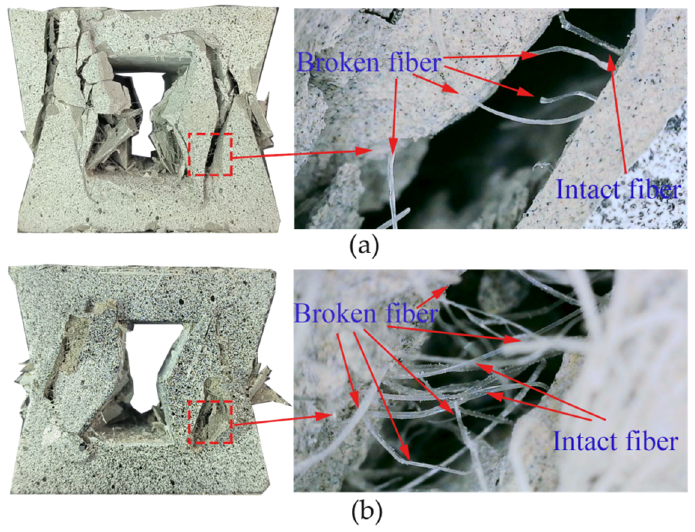
Figure 11. Microscopic morphology of cracks in the concave hexagonal unit cell: ( a ) low fiber content; ( b ) high fiber content.